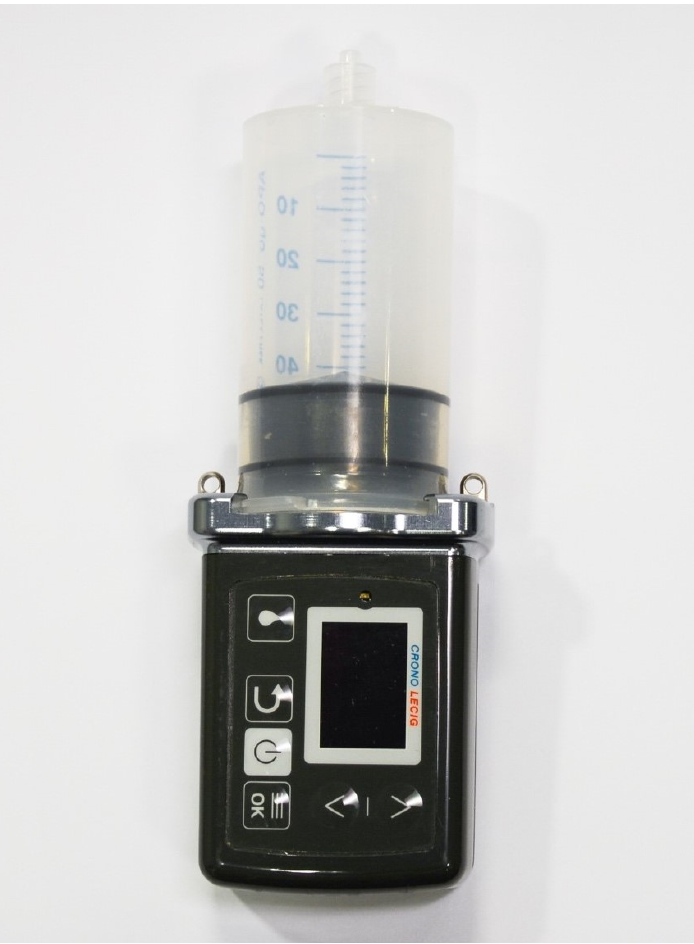
Figure 1. The levodopa–entacapone–carbidopa intestinal gel (LECIG) pump.